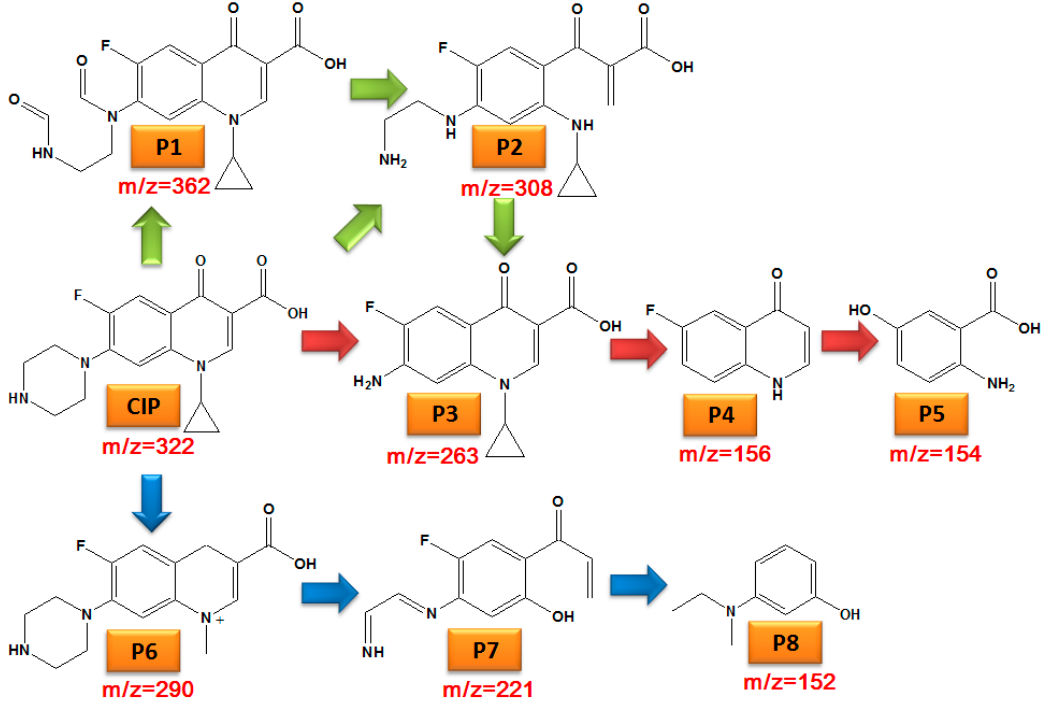
Figure 7. Possible degradation pathway of CIP.